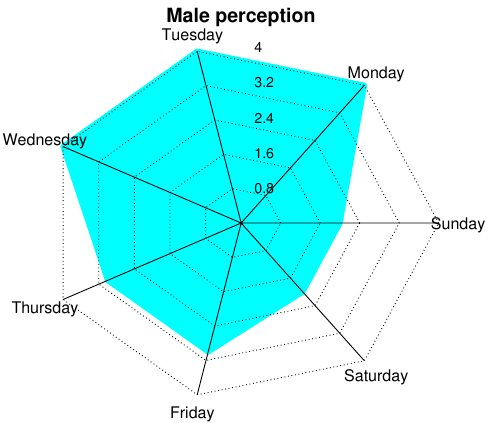
Figure 19. Perception of men about presence of network according to days of week. Female perception